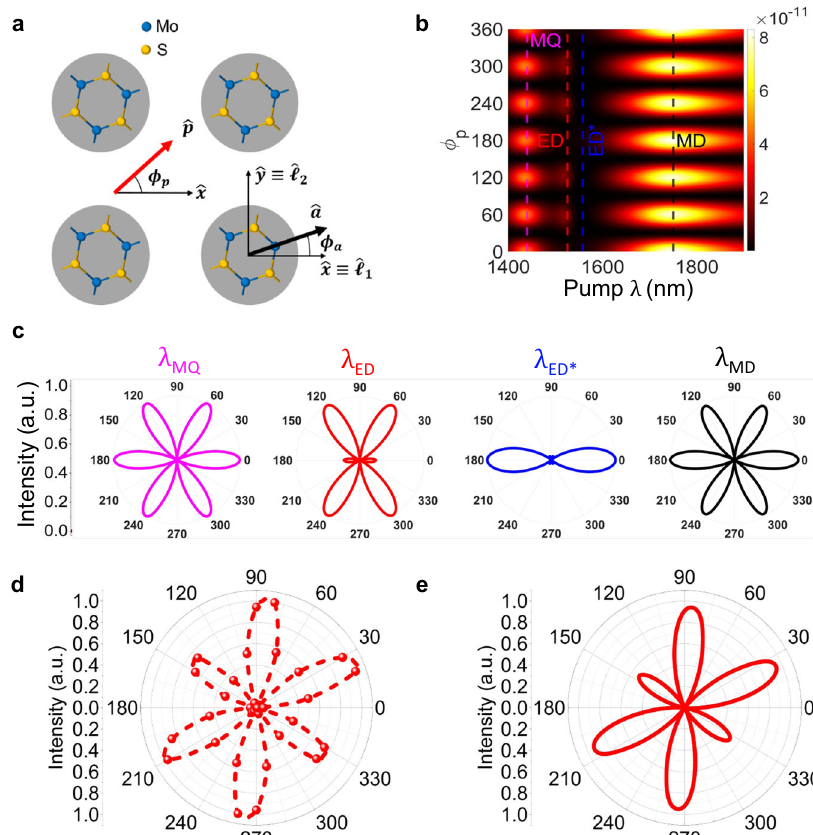
Fig. 6 Polarisation-resolved SHG in a TMDC metasurface. a Schematic of the crystal orientation of the MoS 2 with respect to the metasurface lattice (shown by primitive vectors ^ ‘ 1 and ^ ‘ 2 ) and incident polarisation ( ^ p : polarisation unit vector). The lab frame axis and armchair direction unit vectors are shown by ^ x , ^ y and ^ a , respectively. b Simulated polarisation resolved SHG, in the forward direction, as a function of angle between pump polarisation and lab frame ϕ p and pump wavelength when angle between armchair direction and lab frame ϕ a ¼ 0. The vertical dashed lines represent the spectral positions of the magnetic quadrupole (MQ), electric dipole (ED), the point in close vicinity of electri c dipole (ED*), and magnetic dipole (MD). c Polarisation resolved SHG as a function of ϕ p (when ϕ a ¼ 0), at the wavelengths marked MQ, ED, ED* and MD. d Measured polarisation resolved SHG as a function of ϕ p (when ϕ Fig. 7 Directionality switching of the second harmonic emission. a Measured SH directionality in terms of the relative power of the SH emissions in forward direction D F and in backward direction D B directions as a function of the second harmonic wavelength, when angle between pump polarisation and lab frame ϕ p ¼ 0 o . b Measured forward and backward SH directionality at switching wavelength, 1480 nm, as a function of angle between pump polarisation and lab frame ϕ p when angle between armchair direction and lab frame ϕ a ¼ (cid:3) 26 o . c Simulated directionality mapping, as ratio of forward and backward SH emissions ð P SH F = P SH B Þ from the truncated cone (as shown in the inset) metasurface, as a function of pump wavelength and ϕ p , when ϕ a ¼ 0 o